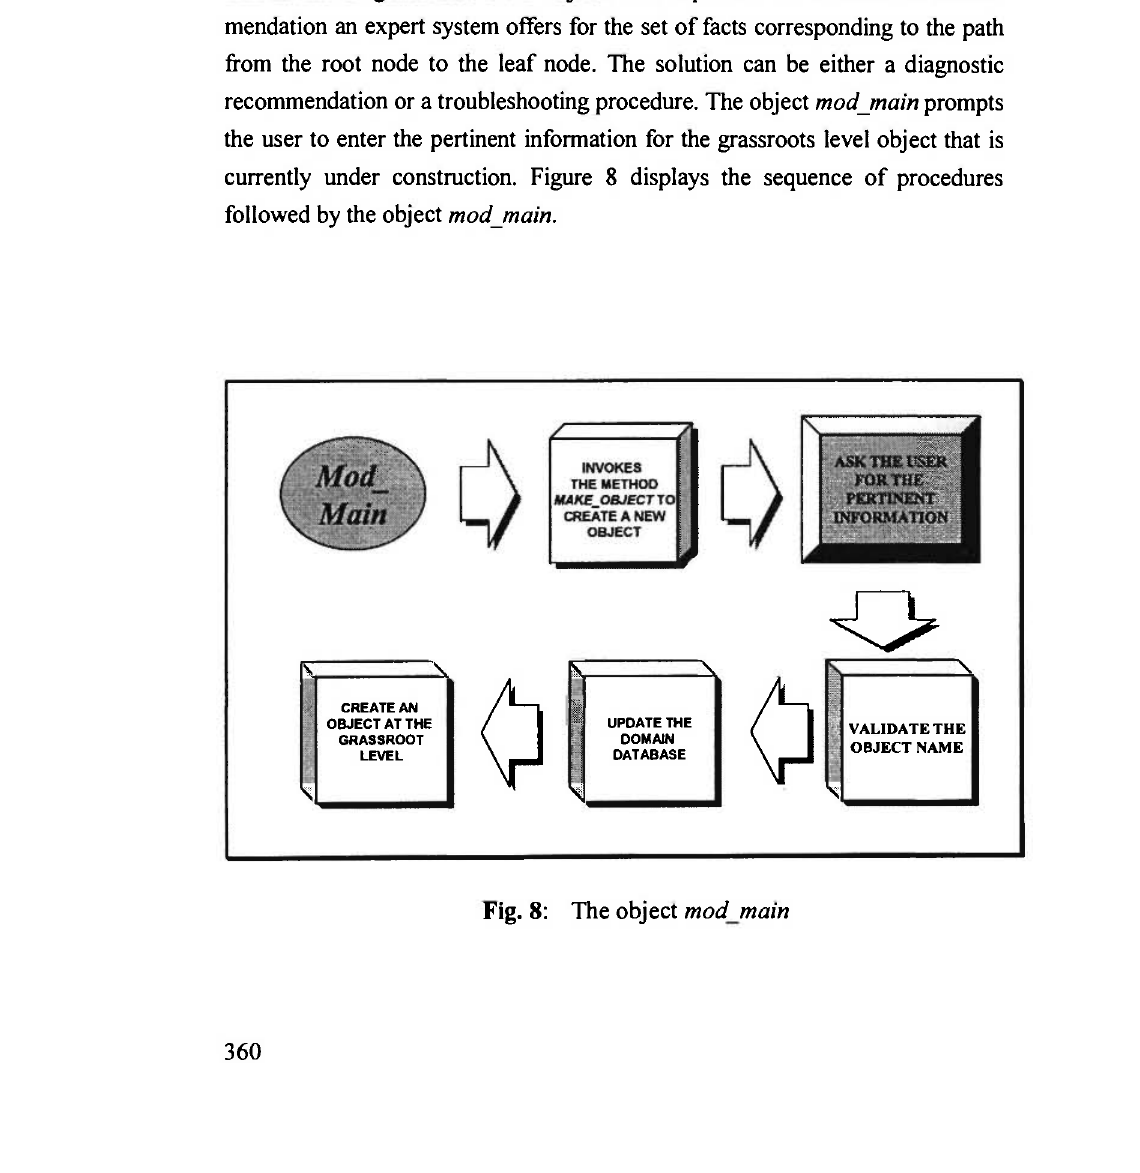
Fig. 8: The object mod